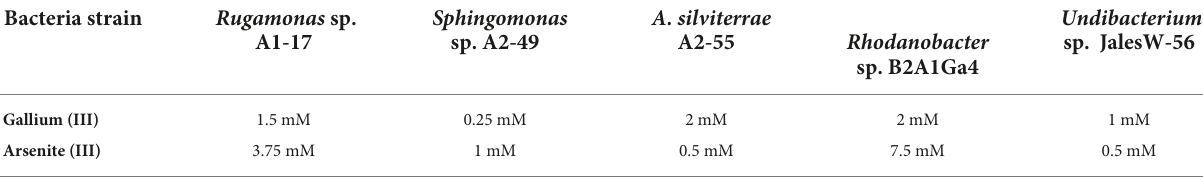
TABLE 4 Minimum inhibitory concentration (MIC) for the different mine bacteria strains. Bacteria strain